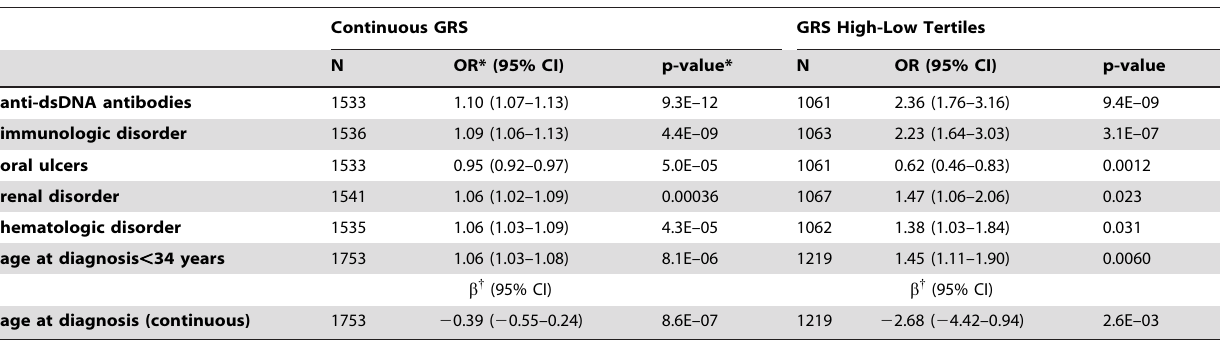
Table 3. Association of GRS with SLE subphenotypes.